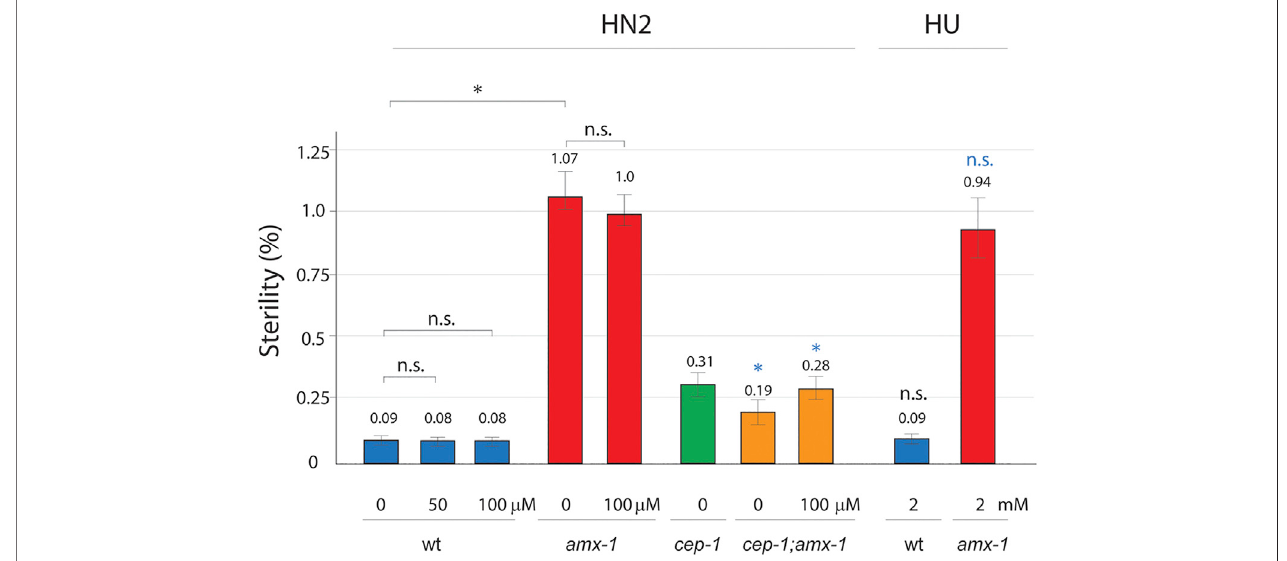
FIGURE 5 | Sterility requires DNA damage-independent function of p53. Sterility was scored among the progenies of indicated genotypes with or without DNA damage treatment. Worms were incubated with or without HN2 (nitrogen mustard) and HU (hydroxy urea) treatment at indicated doses (0, 50, 100 μ M HN2, and 0, 2 mM HU). Asterisks indicate statistically signi fi cant changes. Black colored asterisks or n.s indicate statistic comparison over wild type. Blue colored asterisks or n.s. indicate statistic comparison over amx-1 mutants. Error bars represent standard errors of the mean. At least three independent biological replicates have been performed. n = 1000 – 3624 worms for each analysis.